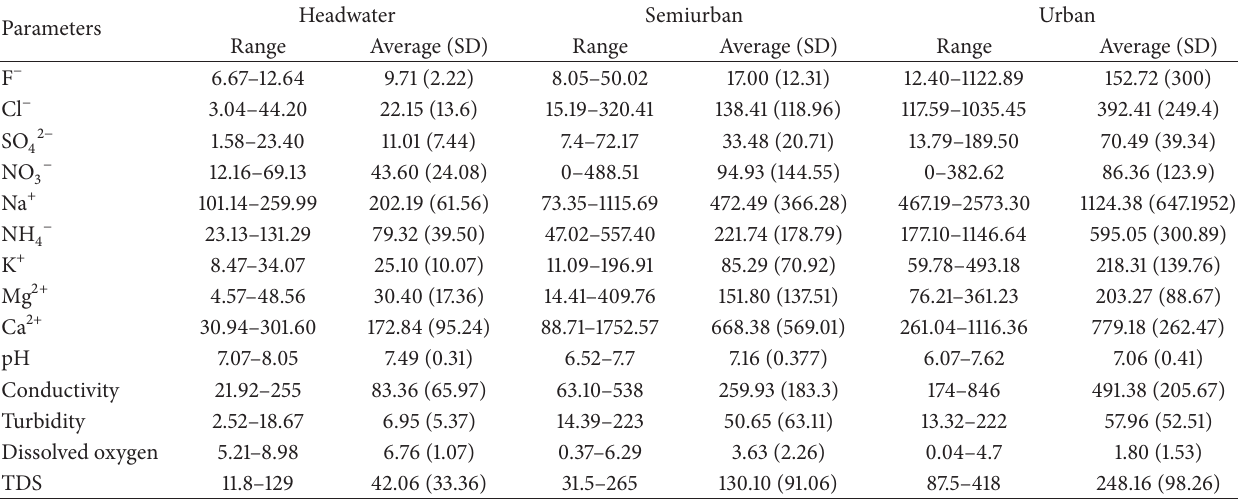
Table 1: Variation of measured major ions ( 𝜇 eq/L), conductivity ( 𝜇 S/cm), turbidity (NTU), DO (mg/L), and TDS (mg/L) in three different sections of the Bagmati River basin within Kathmandu Valley. Values in brackets indicate standard deviation.